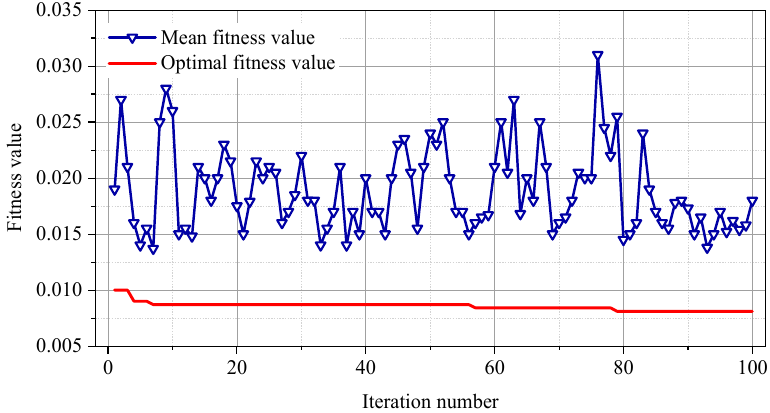
Figure 4. Particle swarm optimization (PSO) iterative optimization curve.